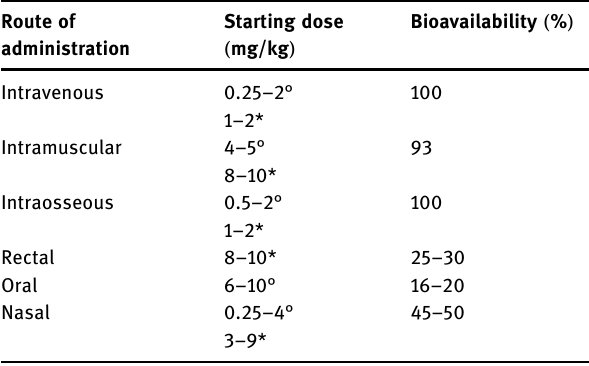
Table 1: Proposed dosages of ketamine and bioavailability Route